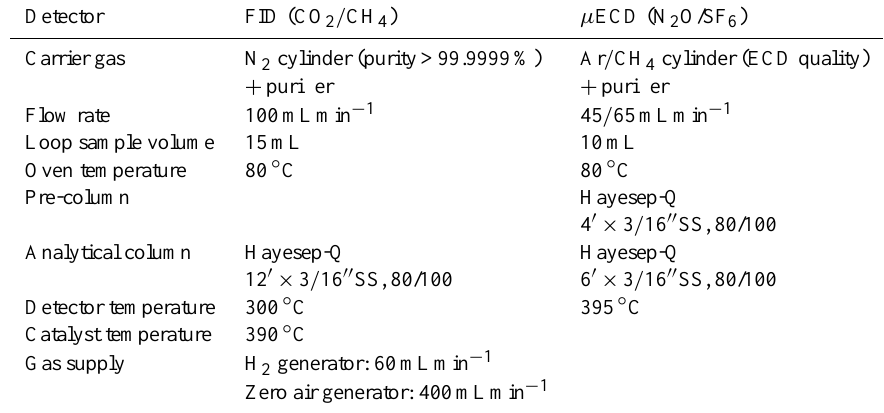
Table 2. GC system equipment and temperature and flow rate settings.